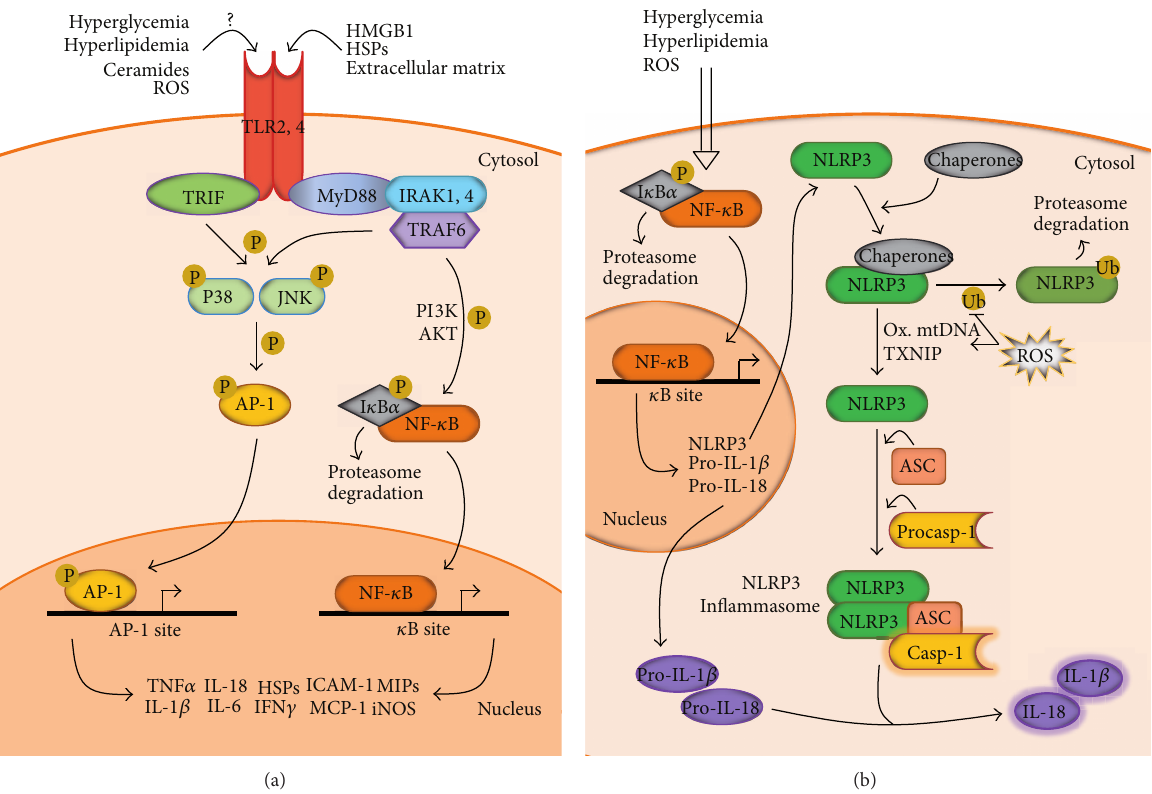
Figure 1: TLRs and NLRP3 inflammasome activation in the proinflammatory myocardium. (a) Activation of TLR2 and TLR4, (b) and NLRP3 inflammasome complexes in